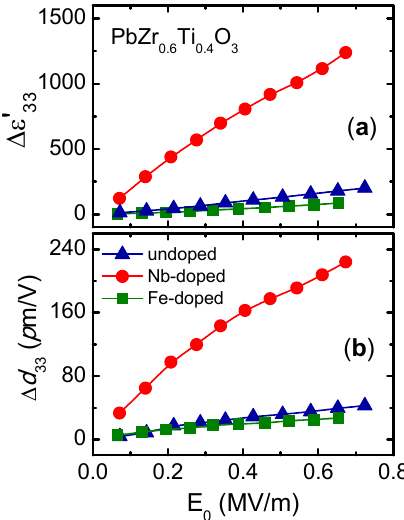
Figure 6. Increments in ( a ) the dielectric constant and ( b ) the converse piezoelectric coefficient as a function of the applied electric field amplitude for undoped, Nb ‐ doped, and Fe ‐ doped Pb(Zr 0.60 Ti 0.40 )O 3 . The data were extracted from the reference [26] (Copyright AIP Publishing LCC., 2008).